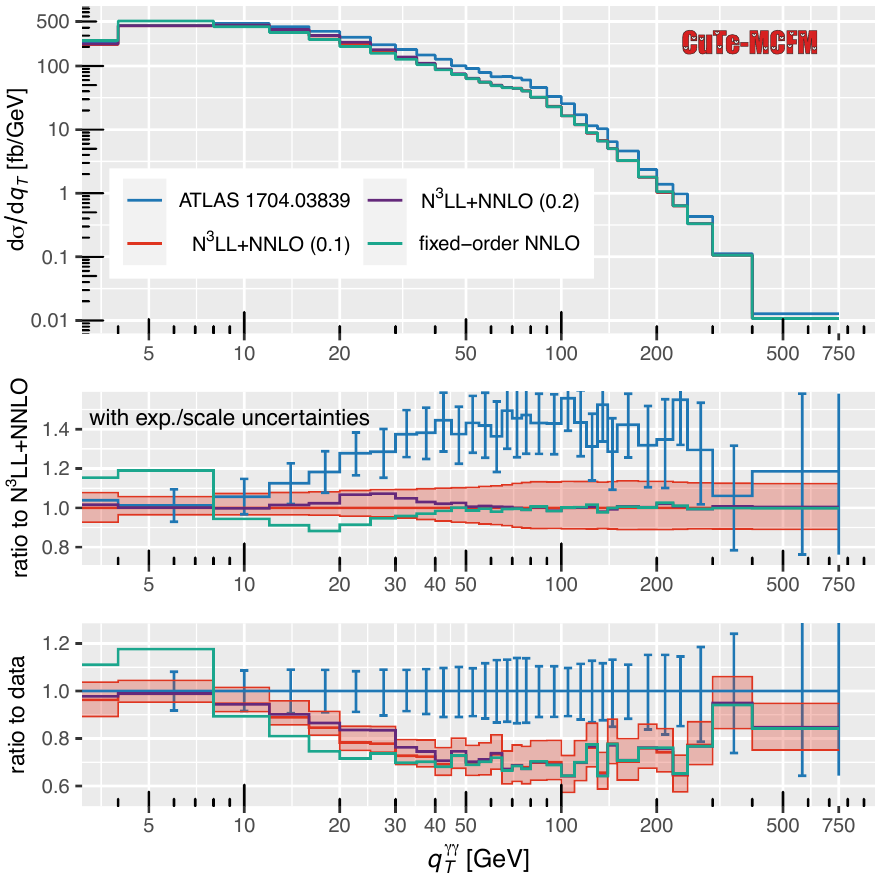
Figure 18. Comparison of the ATLAS measurement of the diphoton transverse-momentum dis- tribution at 8 TeV with predictions at N 3 LL+NNLO including uncertainties associated with scale variation. The labels 0 . 1 and 0 . 2 in the plots refer to the value of x max